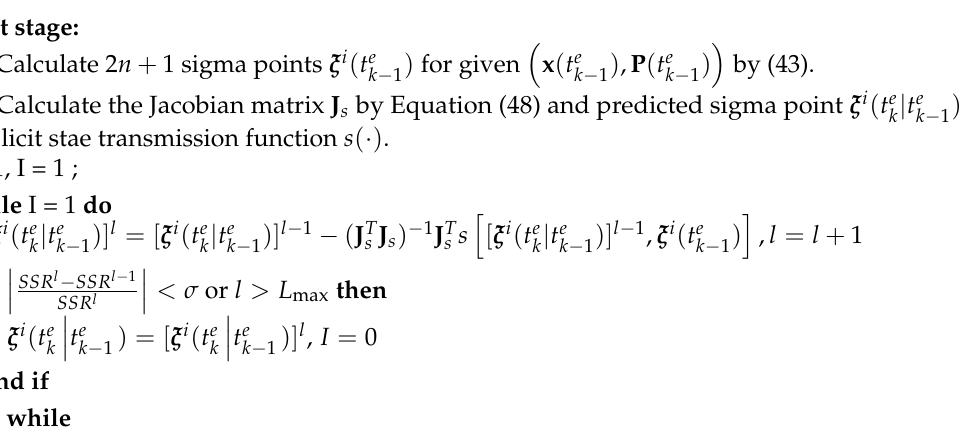
Algorithm 1 The GH-IUKF